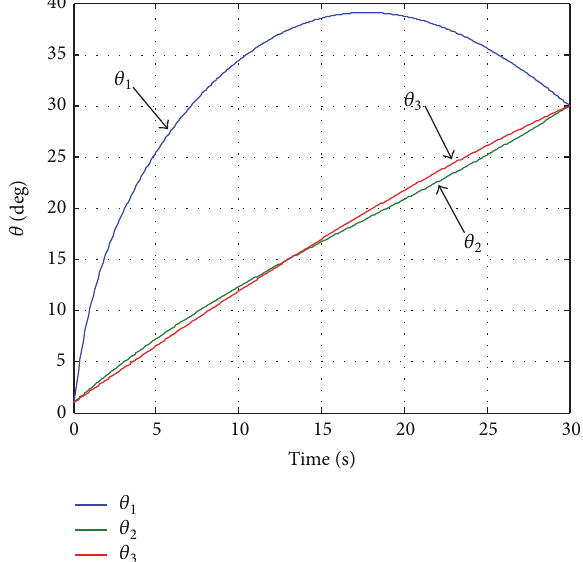
Figure 6: Joints angular displacement with constraint point (simu- lation